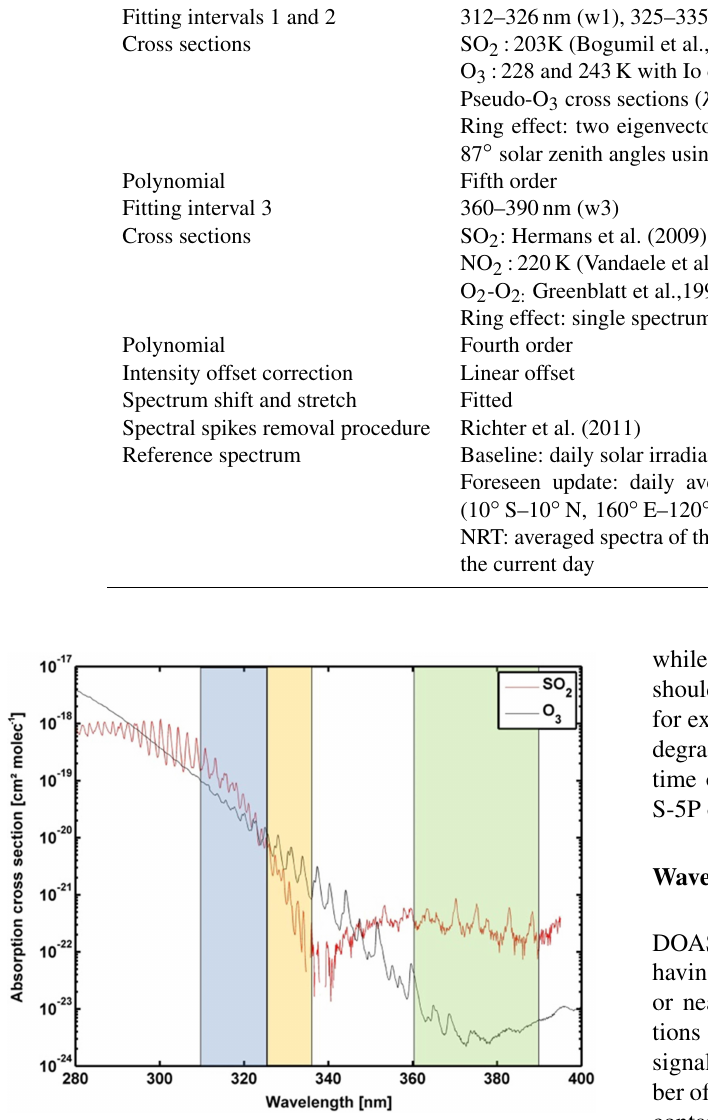
Figure 3. Absorption cross sections of SO 2 and O 3 . The blue, yel- low and green boxes delimit the three SO 2 fitting windows 312– 326, 325–335 and 360–390nm,